Question: Which visualization type does this figure use?
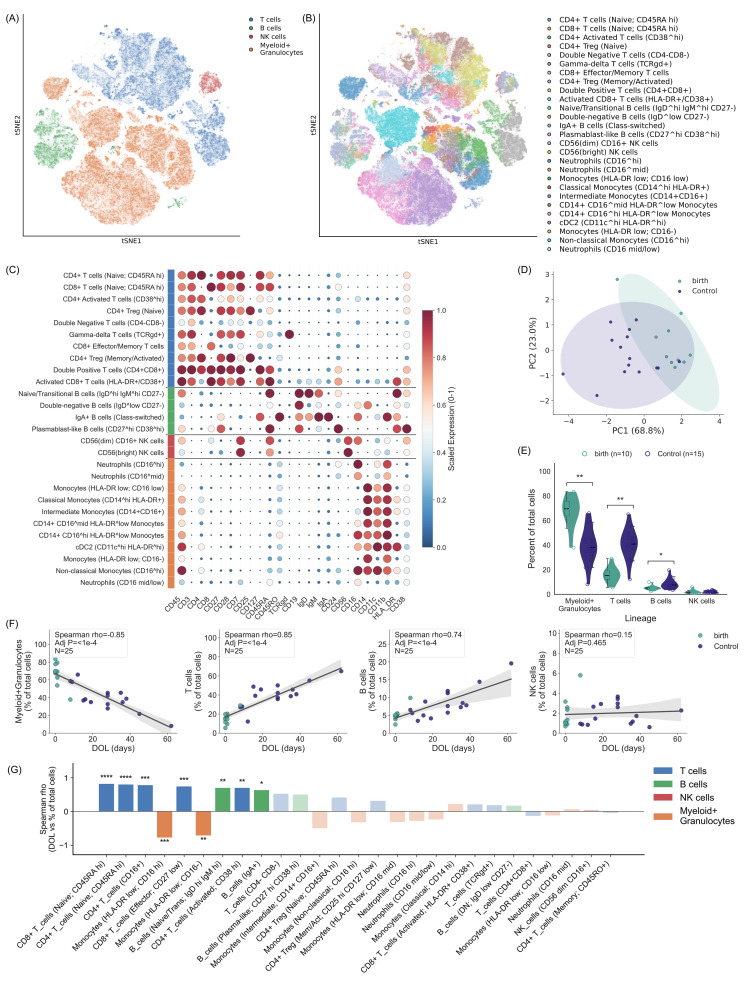
Answer: scatter